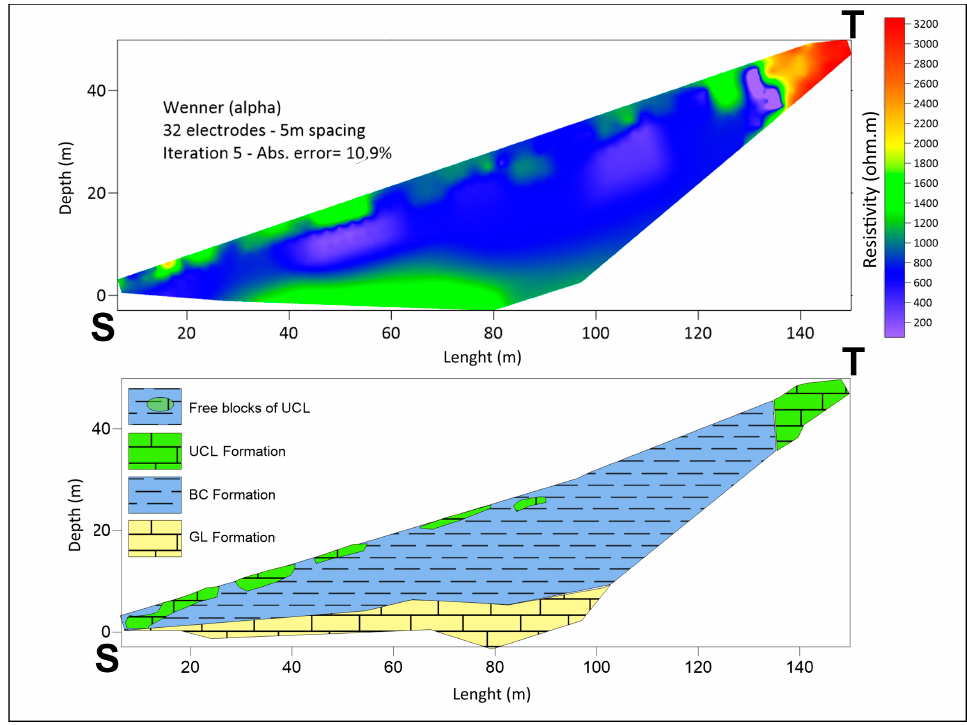
Figure 5. ERT array (S-T) on the slope of Selmun promontory (Malta) and its geological interpreta-